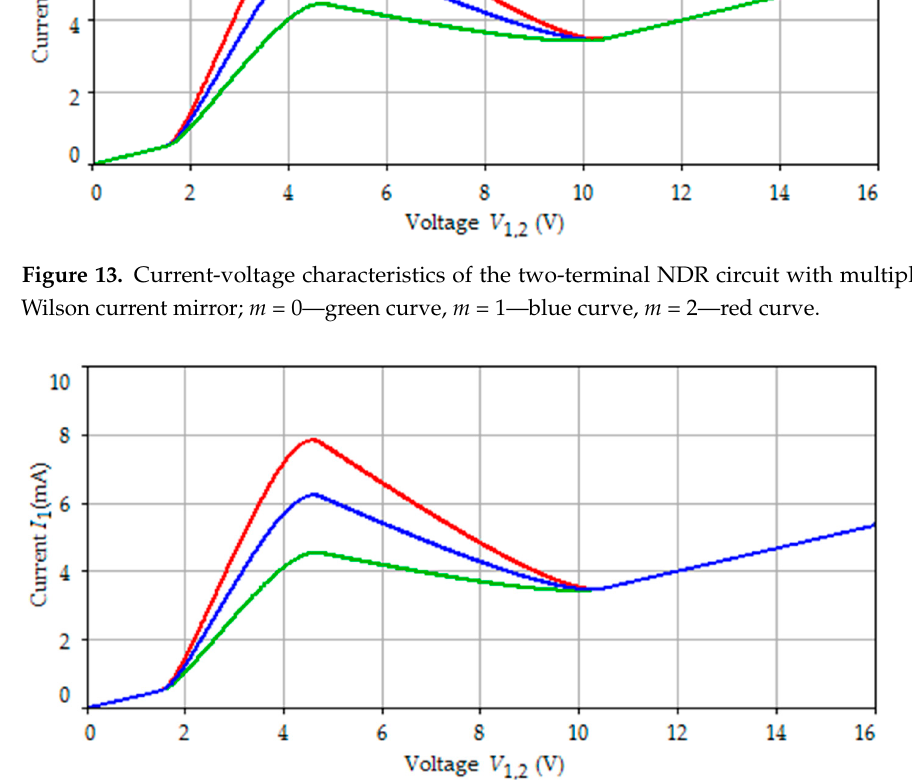
Figure 14. Current-voltage characteristics of the two-terminal NDR circuit with multiple-output improved Wilson current mirror; m = 0—green curve, m = 1—blue curve, m = 2—red curve.